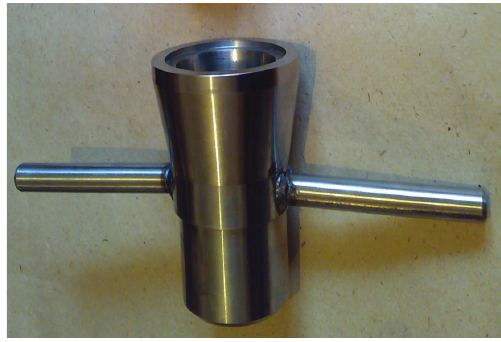
Figure 3: Commercial metal mould.